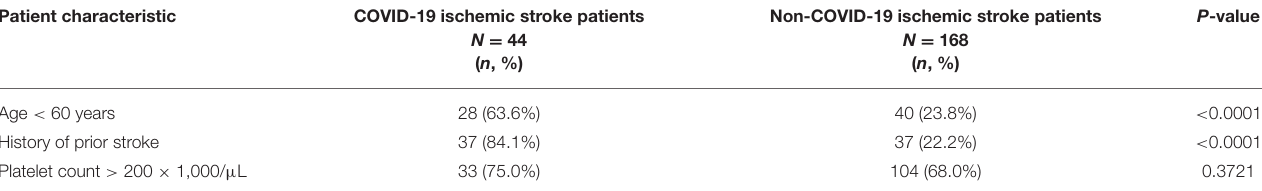
TABLE 5 | Comparing COVID-19 ischemic stroke vs. non-COVID 19 ischemic stroke patients. Patient